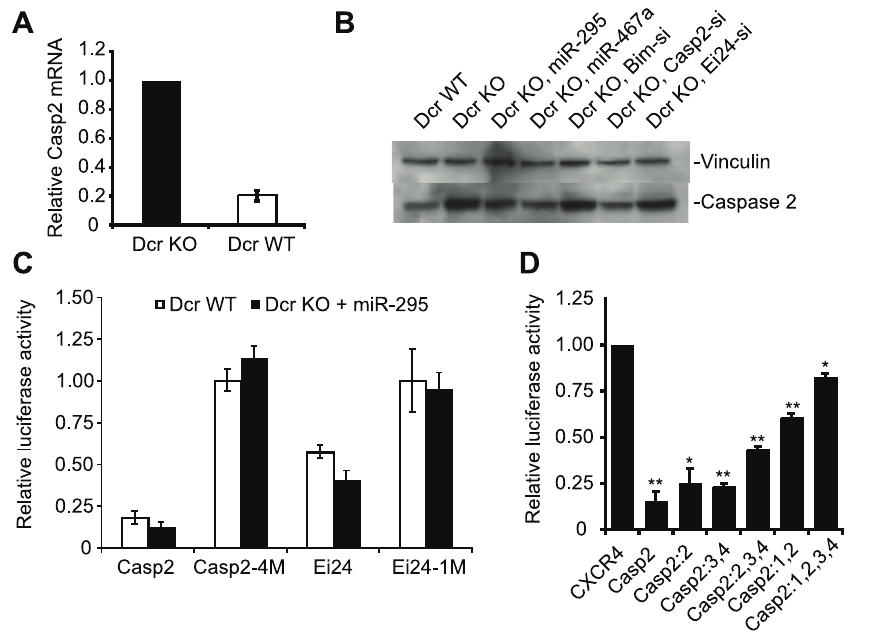
Figure 3. The pro-apoptotic genes Caspase 2 (Casp2) and Ei24 are direct targets of the mir-295 cluster. A. RT-PCR of Casp2 mRNA in Dcr KO cells. B. Western blot of Casp2 in Dcr WT and Dcr KO ES cells. 50 nM miR-295, miR-467a, Bim siRNA, Casp2 siRNA and Ei24 siRNA were transfected into Dcr KO ES cells, and Casp2 protein expression was assayed 24 hours later. miR-467a shares the same hexamer seed with miR-295, and Bim siRNA and Ei24 siRNA served as negative controls. C. Luciferase reporters with a full length Casp2 3’ UTR or Ei24 3’ UTR, as well as their seed mutant versions were assayed by comparing their activities in Dcr WT and Dcr KO ES cells. Casp2:4M has all 4 AAGUGC seed binding sites mutated, and Ei24:1M has its single AAGUGC seed binding site mutated. 20 nM miR-295 was transfected into Dcr KO ES cells and the relative activity measured versus non- transfected cells to test if the repression of luciferase reporters is specifically due to AAGUGC miRNAs. D. Casp2 luciferase reporters bearing different combinations of AAGUGC seed binding site mutations were tested in Dcr WT and Dcr KO ES cells. Casp2:2 , 2nd AAGUGC binding site was mutated; Casp2:3,4 , 3rd and 4th binding sites were mutated; Casp2: 2,3,4 , 2nd, 3rd, and 4th binding sites were mutated; Casp2:1,2 , 1st and 2nd binding sites were mutated; Casp2: 1,2,3,4 , all binding sites were mutated. n $ 3 for all experiments, and results are shown as mean 6 S.E.M. (standard error of the mean). P-values were obtained by t-tests, * denotes p # 0.05, and ** denotes p # 0.01.